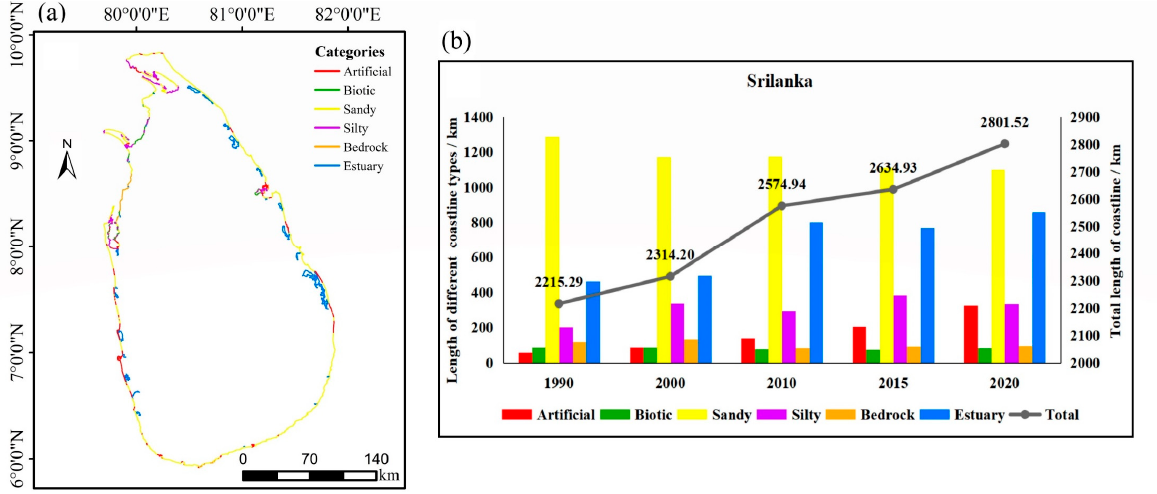
Figure 8. The coastline in Sri Lanka. ( a ) Spatial distributions of coastline in 2020 and ( b ) length statistics of different coastline types from 1990 to 2020.